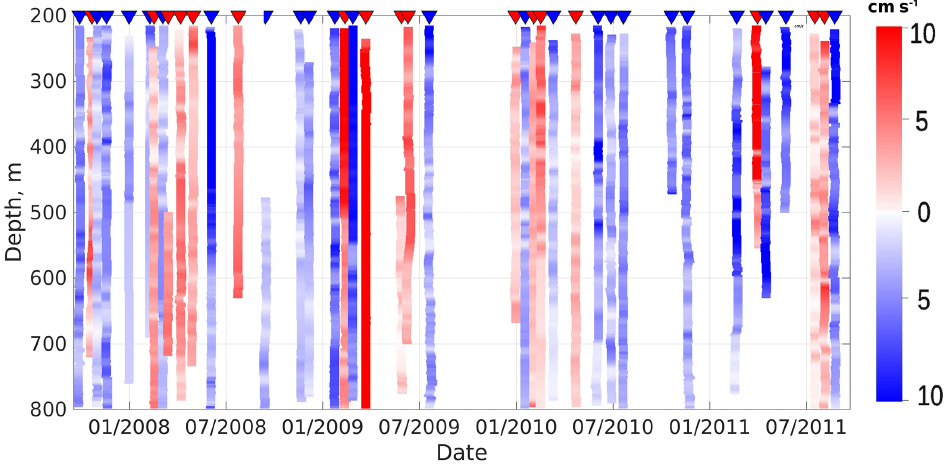
Figure 4. Results of wavelet-based identification of eddies using the MMP record at the M1f mooring over the Laptev Sea continental slope in 2007–2011. Each vertical color stripe represents a single eddy. Red is used for anticyclonic rotation; blue is used for cyclonic rotation. Color intensity shows the rotational speed of eddies (cms − 1 ). Color triangles on top of the panel indicate the time when an eddy “pseudo” center passes the mooring site.